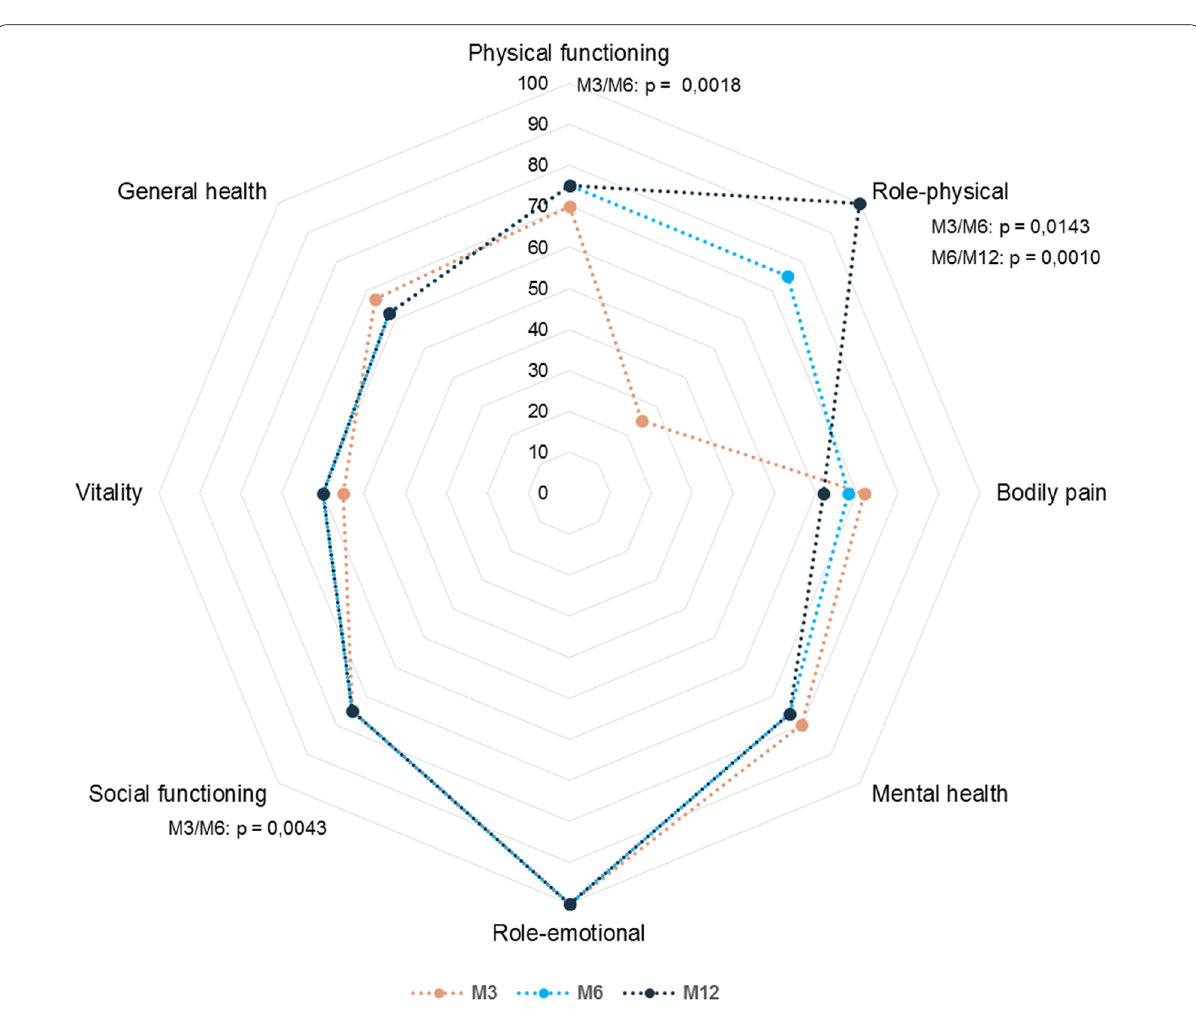
Fig. 2 Results of Quality of Life Assessments at 3, 6 and 12 months using the Medical Outcomes Study Short Form 36‑item questionnaire. Graphic representation of medians MOS SF‑36 subscales 3, 6 and 12 months after symptoms of Sars‑Cov‑2 onset